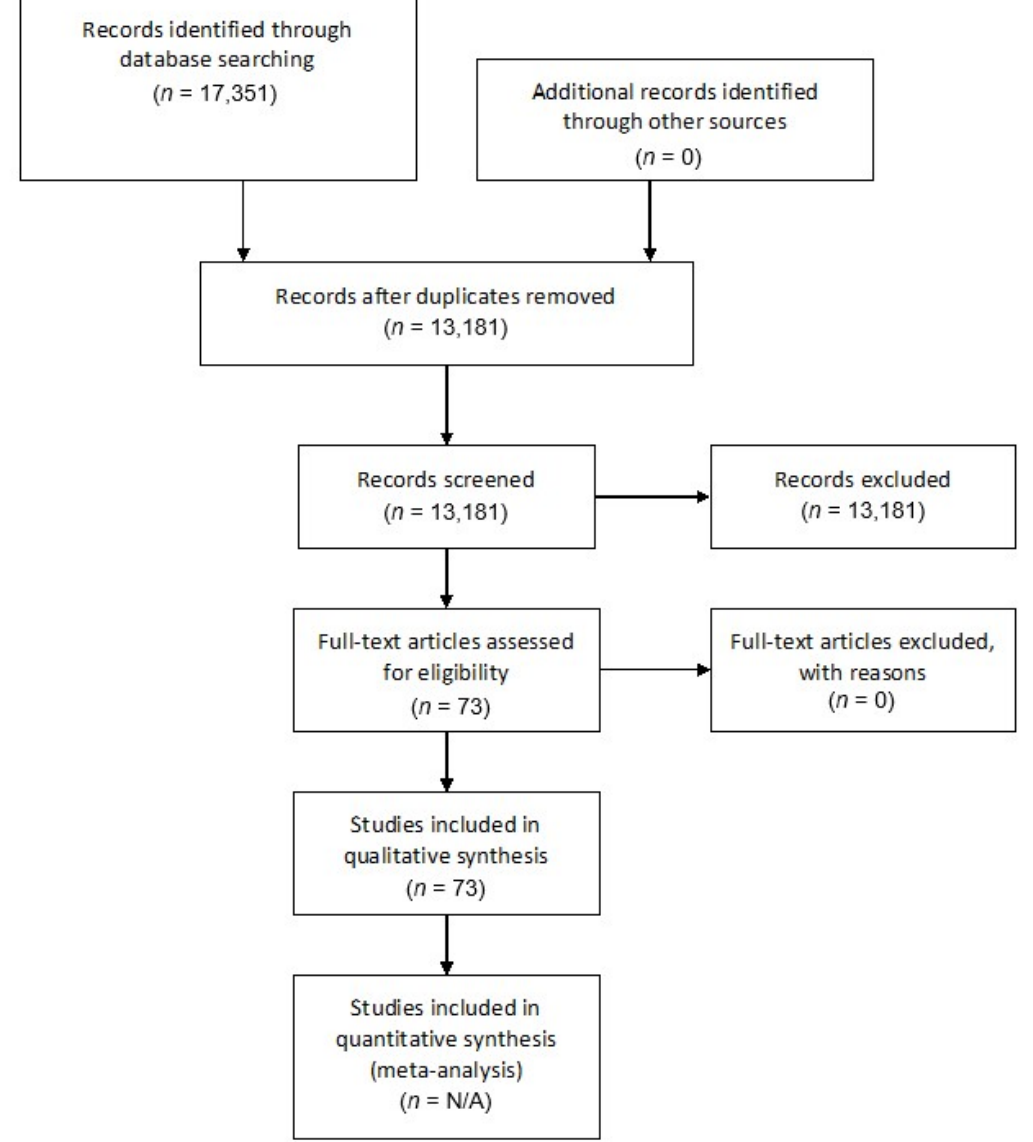
Figure 1. Preferred Reporting Items for Systematic Reviews and Meta-Analyses (PRISMA) flowchart for our systematic review.